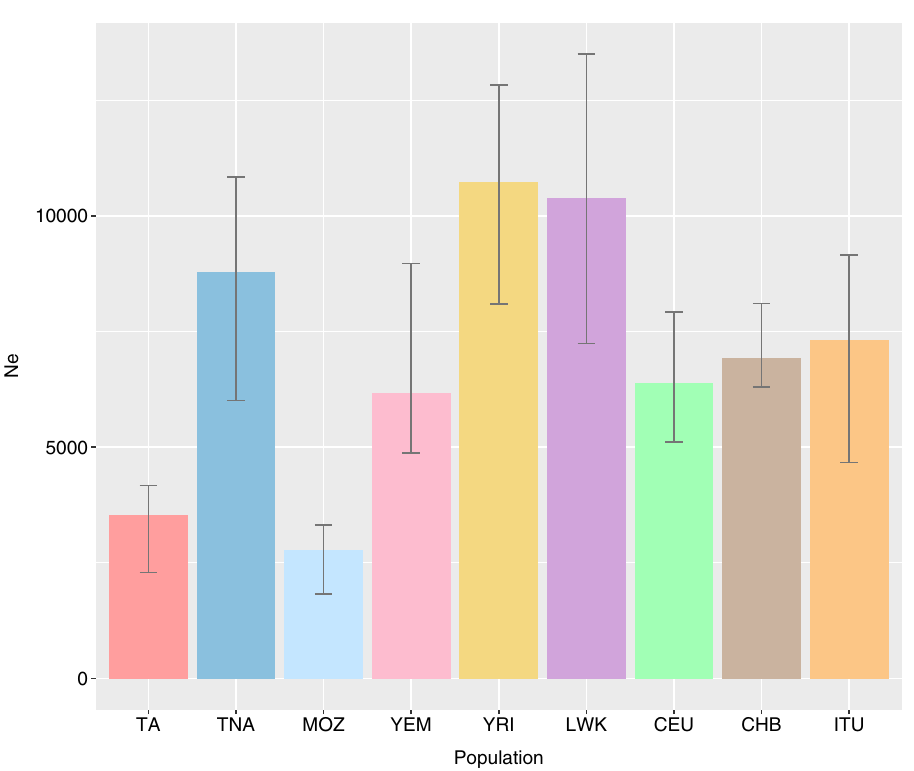
Figure 2. Long-term effective population size. Long-term N e . Error bars indicate the 5th and 95th percentile of the distribution using each chromosome as replicates. Population names abbreviated as in Fig.